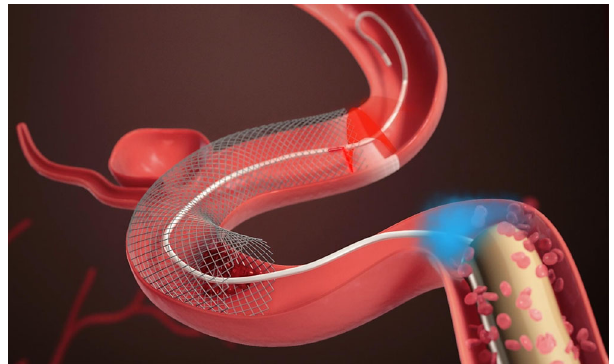
Fig. 1 Principles of HF-OCT imaging in an intracranial vessel. During a brief injection of contrast (blue color) through a 5 F distal access catheter, the Vis-M device is retracted while quickly rotating its internal optics resulting in a helical scanning pattern. By the means of a tightly spaced pattern (e.g., 80 µ m) and an axial resolution approaching 10 µ m, comprehensive volumetric microscopy of the arterial wall, neurovascular devices, and intraluminal objects is